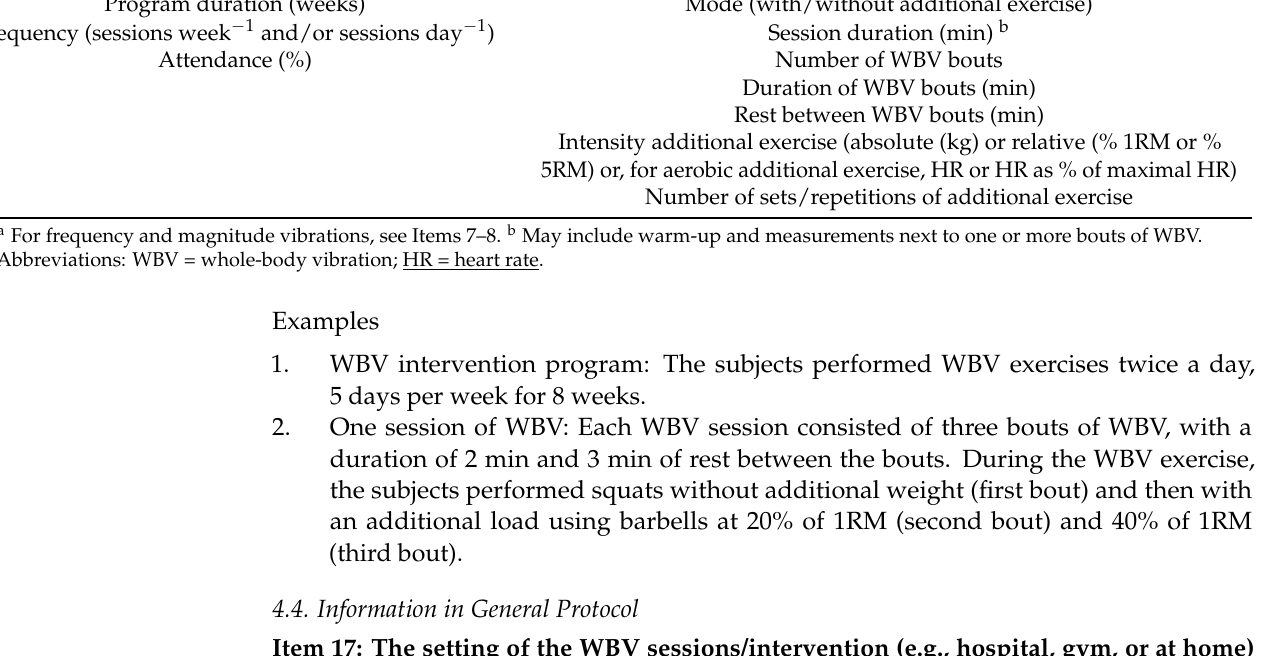
Table 3. General exercise parameters that are possibly relevant for WBV exercise. WBV